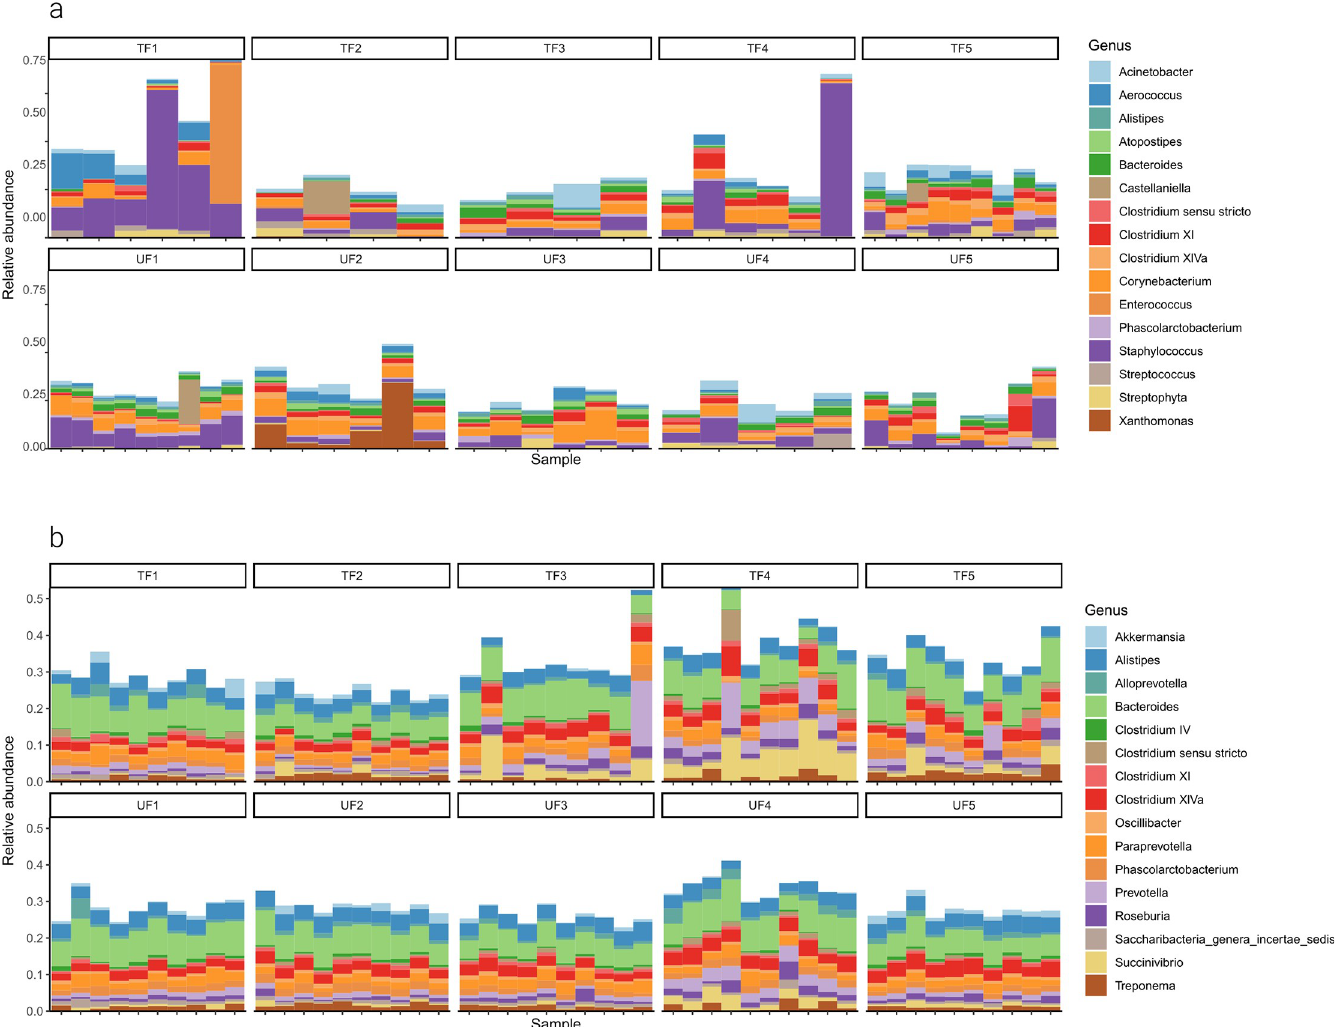
Fig 2. Taxonomic classification by genus of raw milk and fecal microbiota from dairy cows. Relative abundances of the most abundant genera of Alpine dairy cow raw milk (a) and fecal (b) samples across ten herds either fed traditionally (TF) or with unifeed (UF) within the Province of Trento, Italy.